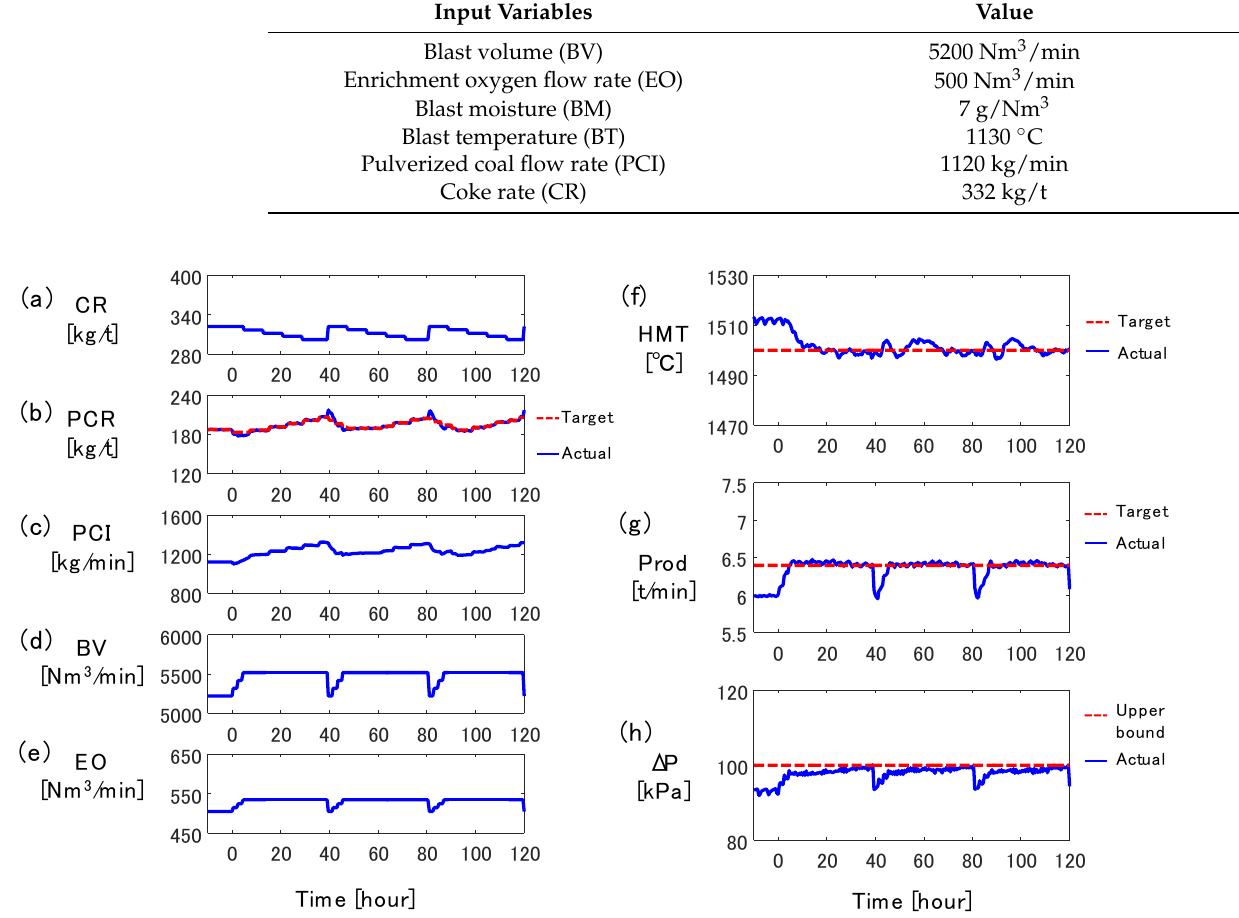
Figure 7. Control simulation result: ( a ) coke rate, ( b ) pulverized coal rate, ( c ) PC flow rate, ( d ) blast volume, ( e ) enrichment oxygen flow rate, ( f ) hot metal temperature, ( g ) production rate, ( h ) pressure drop.